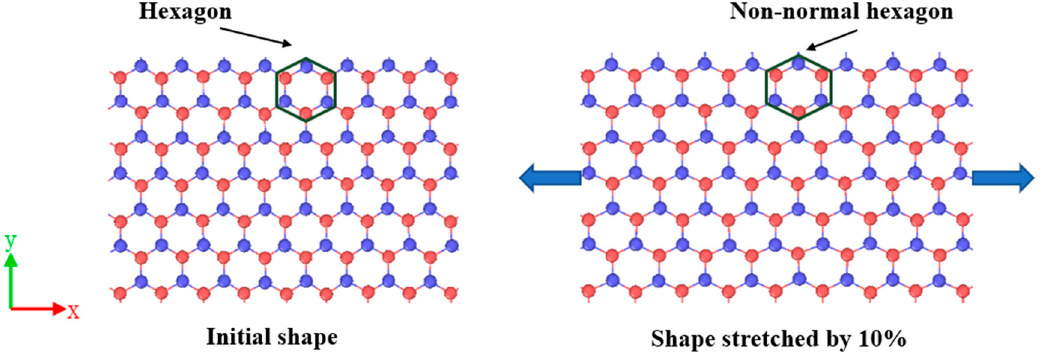
Figure 8. Atomic charge distribution of BN nanosheet under tensile loading.